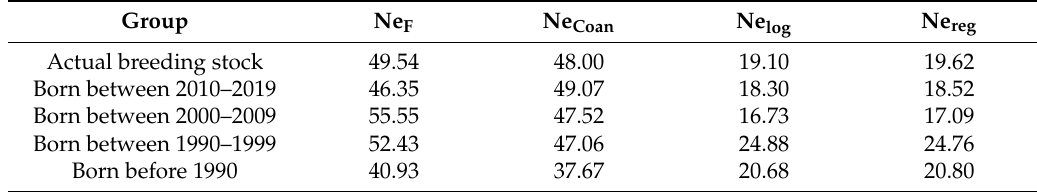
Table 5. E ff ective population sizes of the di ff erent